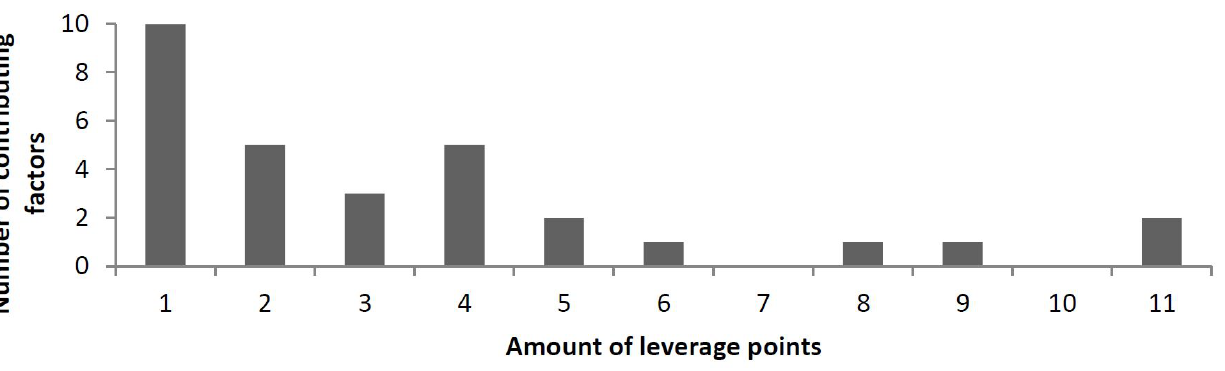
Figure 8. Frequency of leverage points: Number of counts contributing factors targeted by FSC